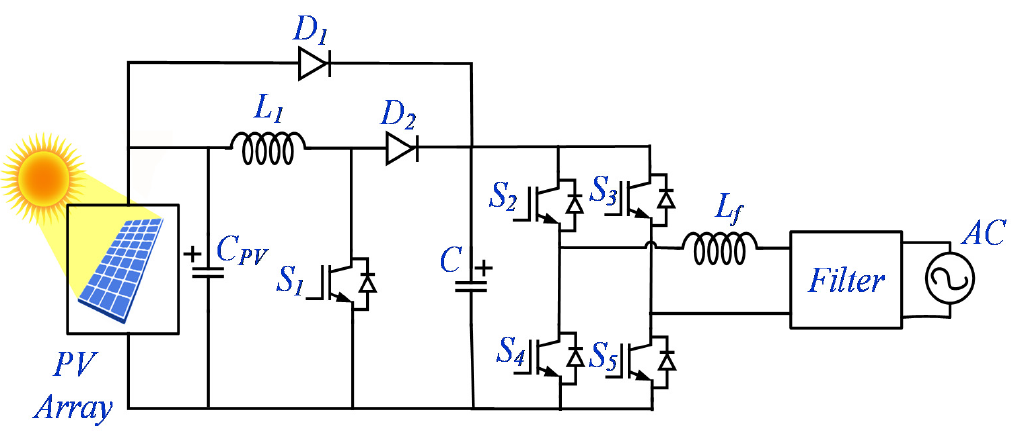
Figure 9. Soft switched parallel resonant boost converter and full-bridge inverter .